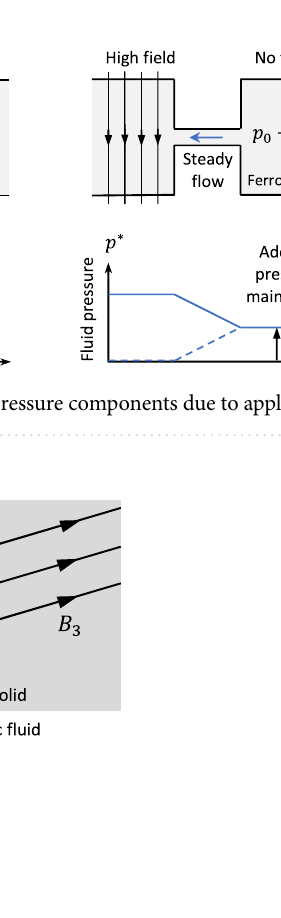
Figure 2. Magnetic field and fluid pressure near an interface with a magnetic